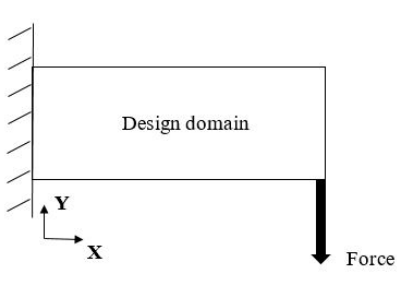
Figure 1. Schematic of design domain and loading condition for cantilever beam.